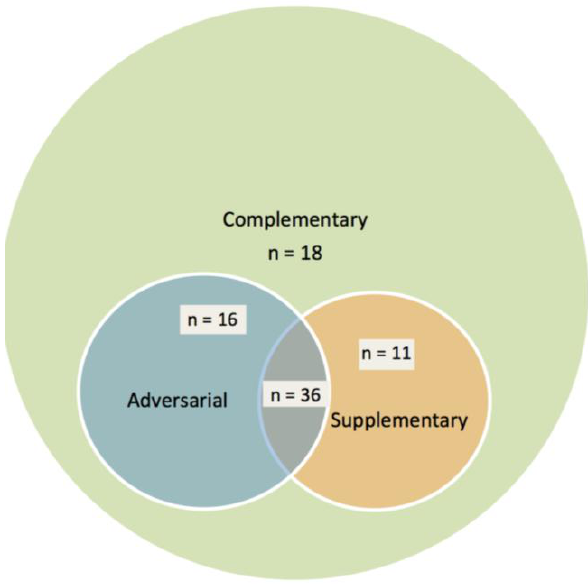
Figure 2. Mix of activities engaged in, by type, in the 2008–2009 school year.